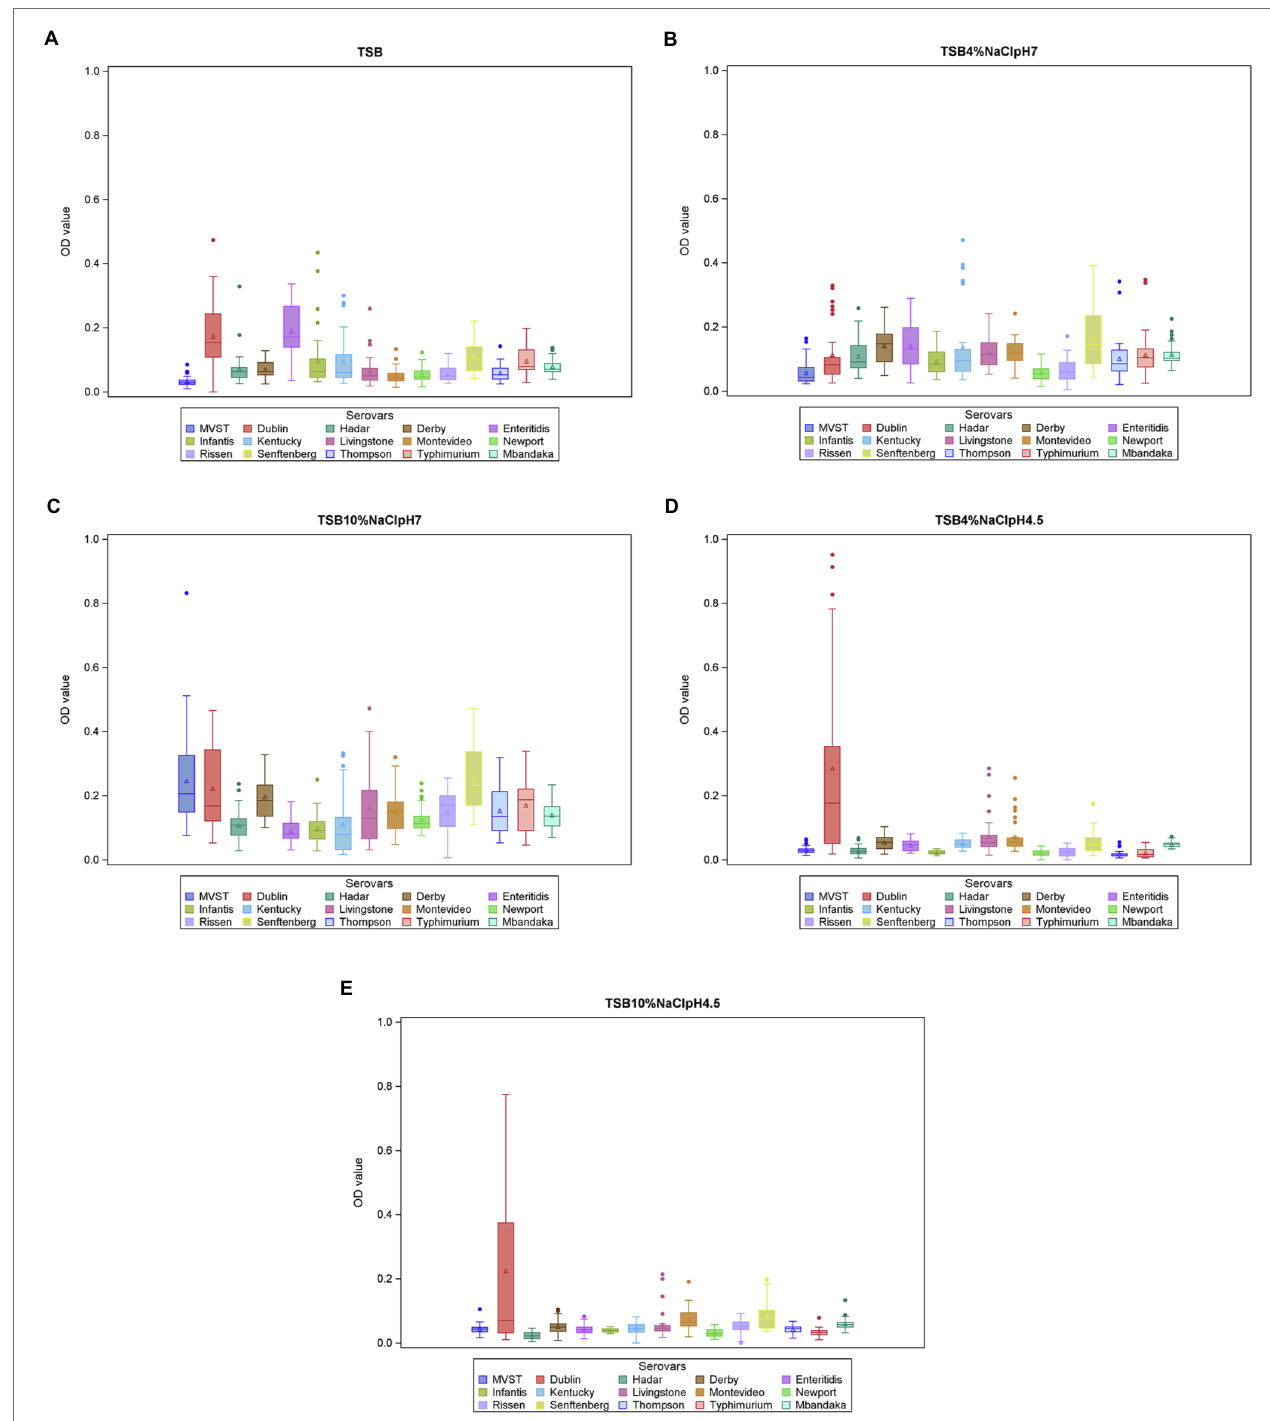
FIGURE 1 | Biofilm formation (OD 570 values) per serotype and experimental conditions ( A = TSB, B = TSB pH7, 4% NaCl, C = TSB pH7, 10% NaCl, D = TSB pH4.5, 4% NaCl, E = TSB pH4.5, 10% NaCl). The boxes define the upper and lower quartiles and enclose the central 50% of the observations. The median is marked by a horizontal line, and the vertical whiskers extend from the box to the 2.5th percentile and the 97.5th percentile. Extreme values are indicated by dots and mean values are indicated by triangles. MVST = monophasic variant of S .